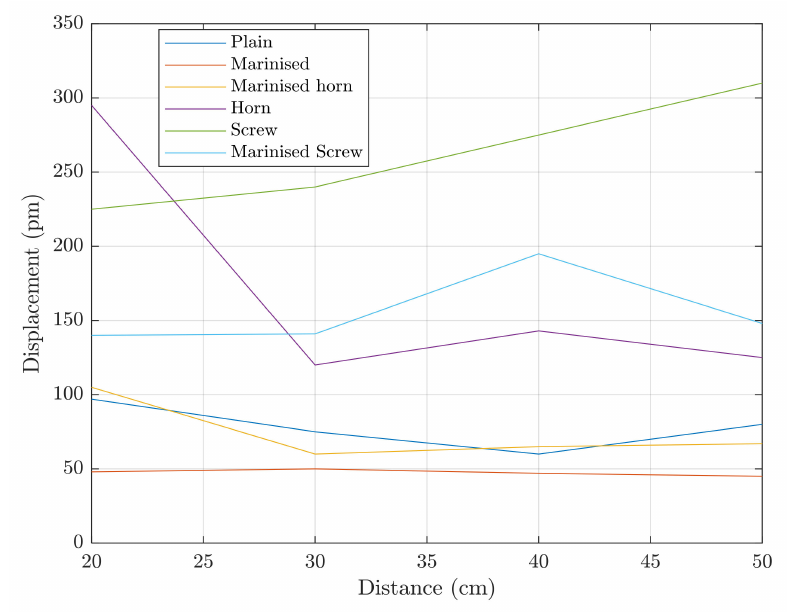
Figure 6. Maximum averaged displacements for different transducer configurations.